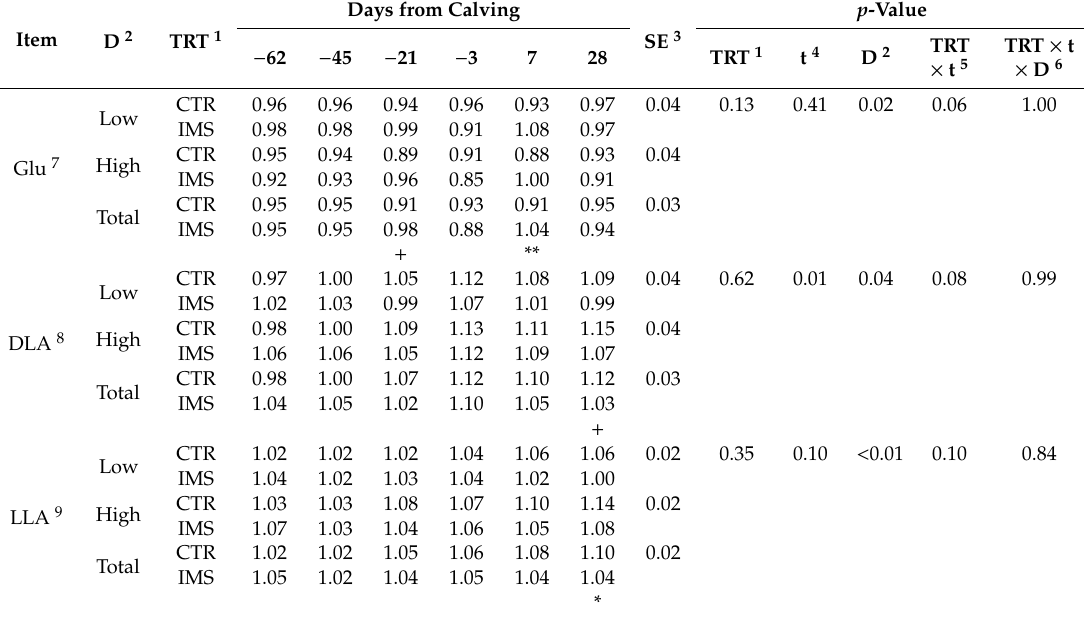
Table 6. Fold change values (expressed with respect to baseline) of energy metabolism biomarkers after a whole blood stimulation assay with a low or high dose of bacterial lipopolysaccharides in control dairy cows (n = 5) or cows receiving 65 g*d − 1 of Omnigen-AF ® as top-dress between − 55 and 42 days from calving (n =